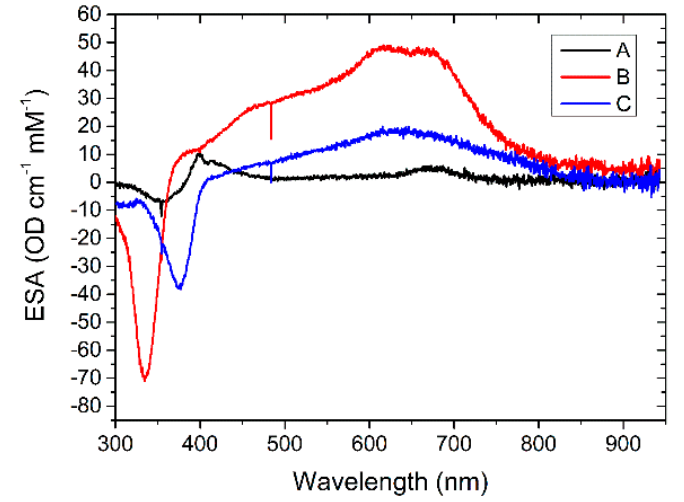
Figure 5. Excited State Absorption (ESA) spectra of molecules “A” (black), “B” (red) and “C” (blue). Ultra-Fast Transient Absorption